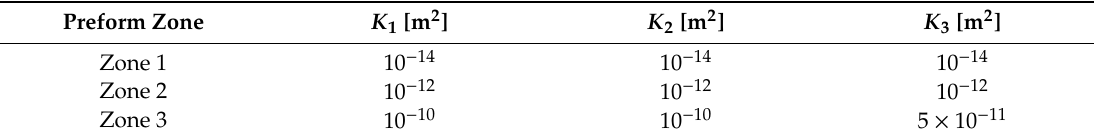
Figure 15. Details of the fuselage section geometry. Table 9. Preform zones and corresponding principal permeability for the fuselage section (permeability K 1 and K 2 are always the in-plane values, while K 3 the through-thickness